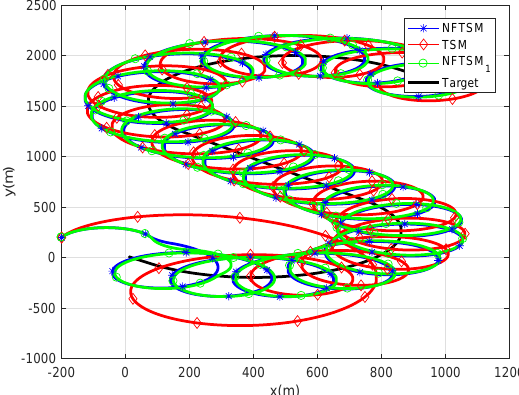
Figure 7. Tracking a moving target along the S-shape trajectory.